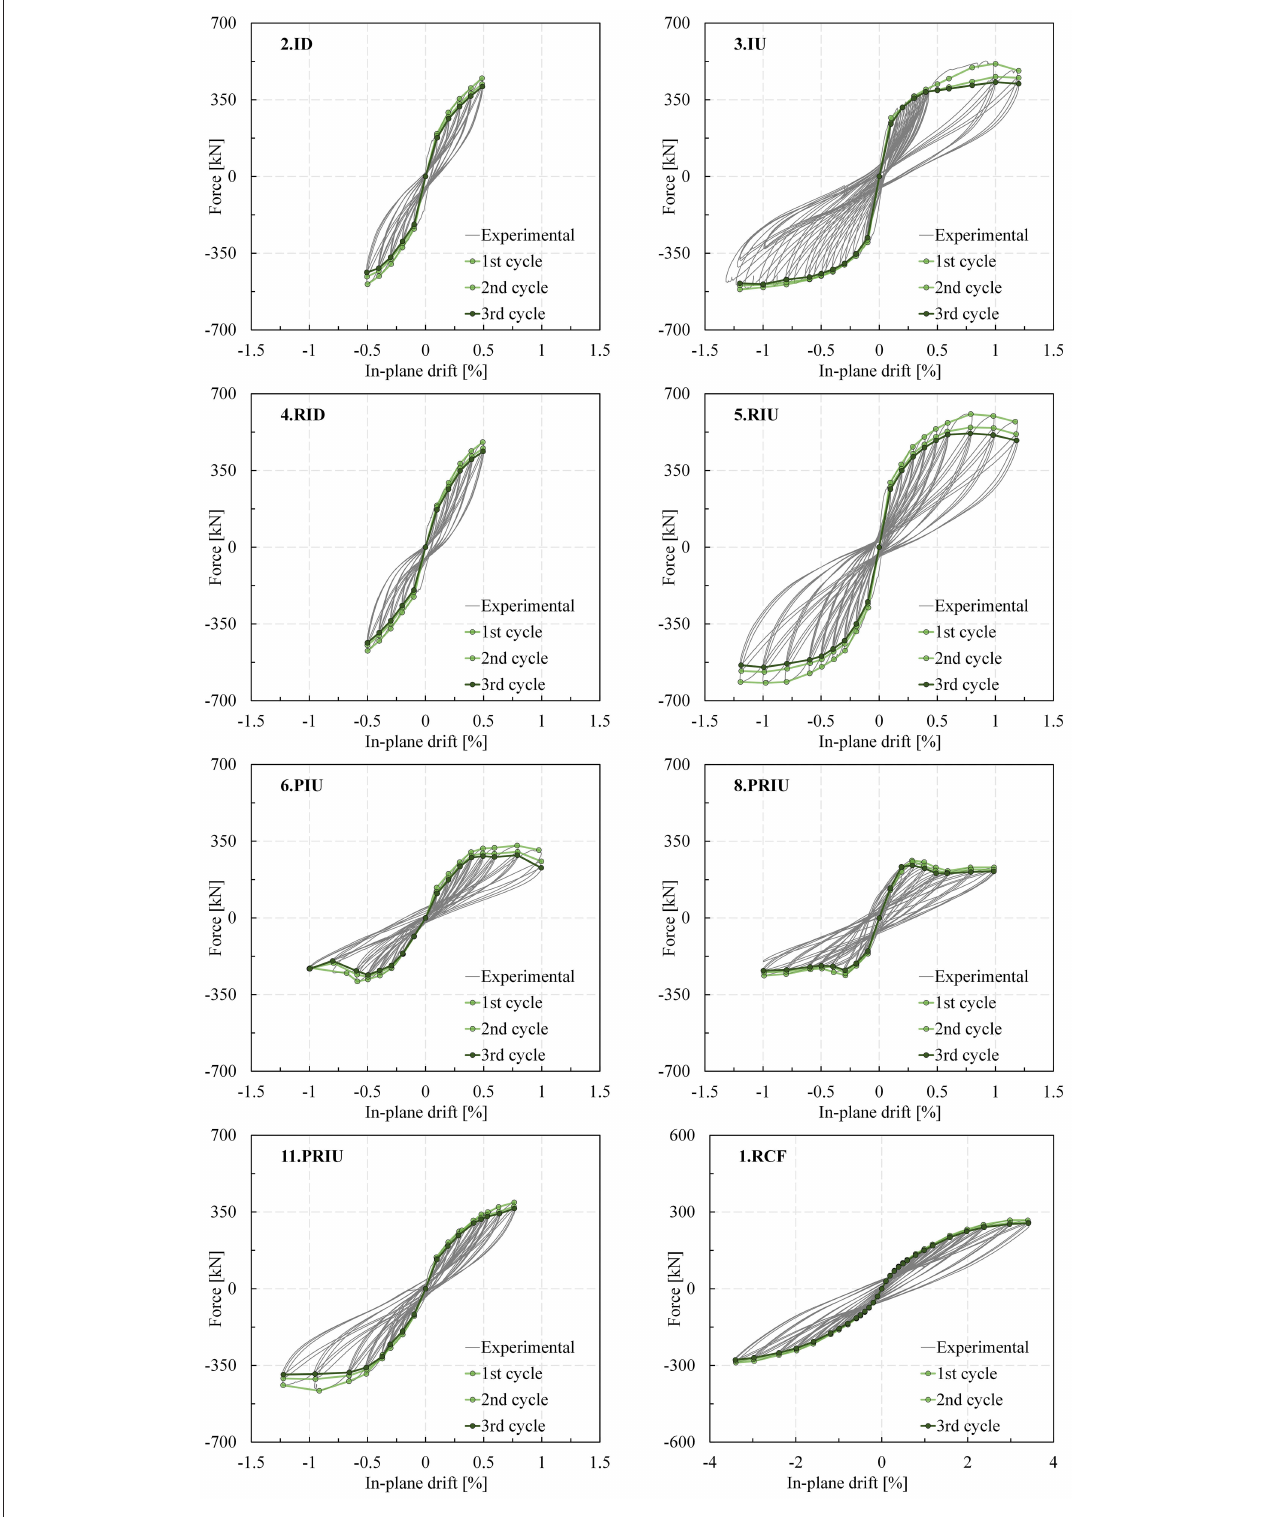
FIGURE 8 | Hysteresis loops and envelope curves of in-plane tests.